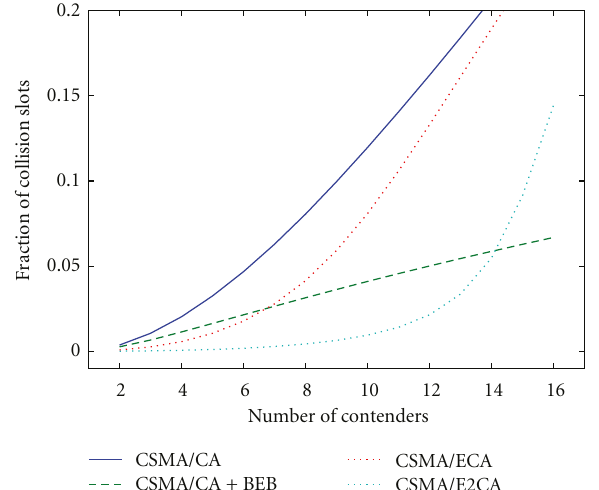
Figure 9: Fraction of collision slots for each of the three protocols under comparison for di ff erent number of contenders in a channel that drops 10% of packets.